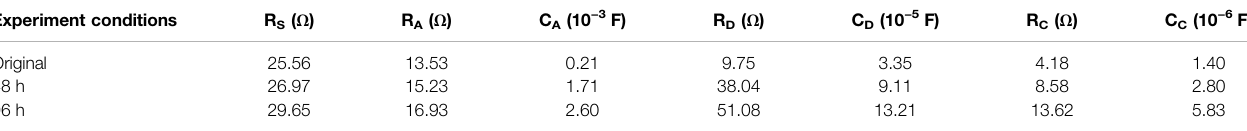
TABLE 3 | Equivalent circuit fi tting results from EIS